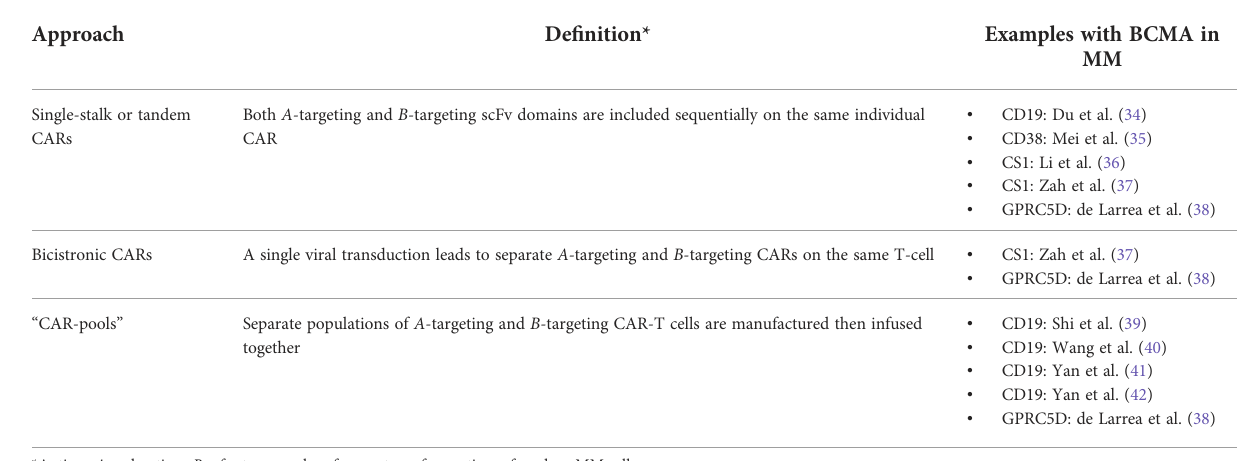
TABLE 1 Classes of dual-targeting CARs in multiple myeloma. Approach De fi nition*